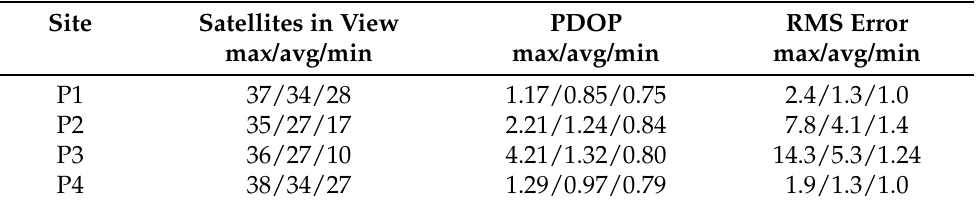
Table 4. Comparison of quad-constellation GNSS receiver performance under different types of environments denoted by the P1, P2, P3 and P4 observation